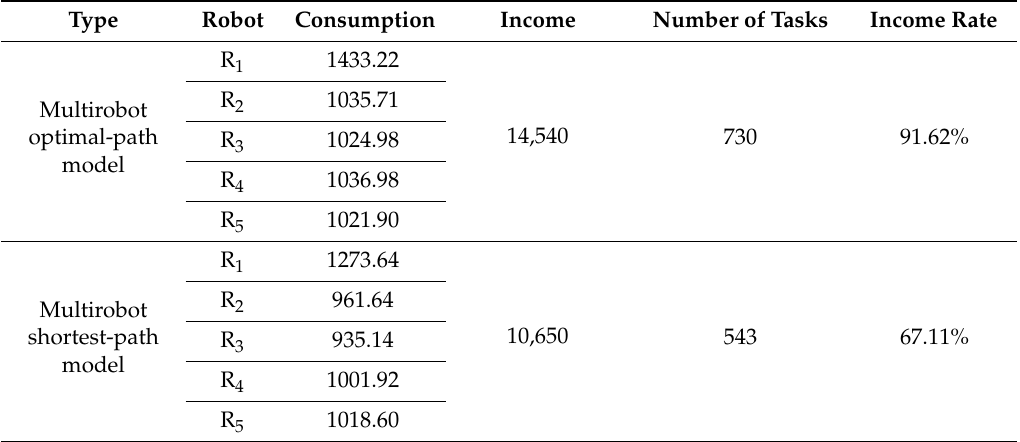
Table 5. Comparison of task-planning paths for a space-robot cluster with a total energy of